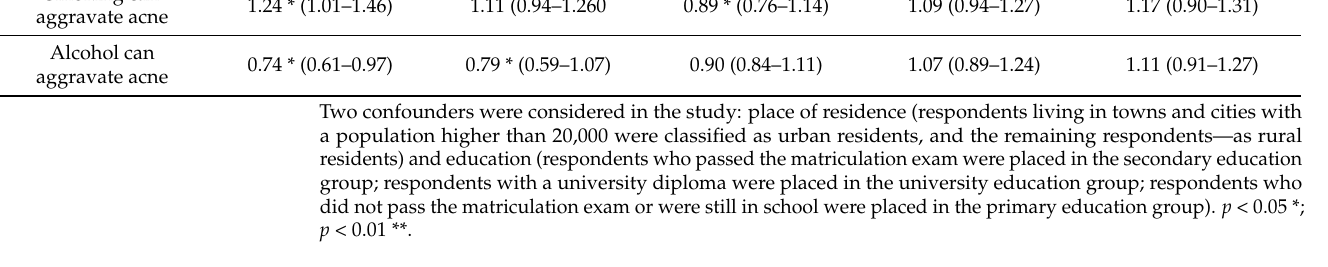
Table 4. Respondent opinions on diet and lifestyle factors that can alleviate